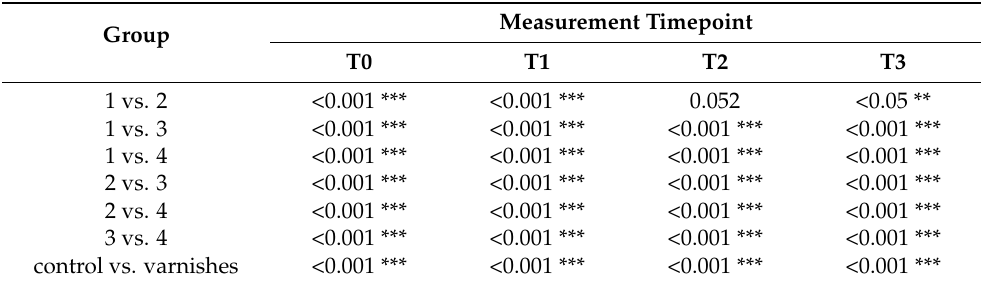
Table 4. Mann–Whitney U test results for differences between groups regarding fluoride release (not corrected for